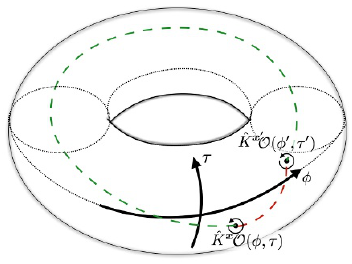
Figure 5 . The bulk local state in BTZ black hole is de(cid:12)ned as a CFT primary operator dressed by the localizing operator ^ K x which is inserted at the point ( (cid:30); (cid:13) ) on a half torus. Two point functions of the bulk local states are calculated on the torus. It can be expressed as a sum of correlators of mirror images. Each contribution comes from the direct path (red dashed line) or an incontractible winding path which goes around the circle along the (cid:30) direction (green dashed